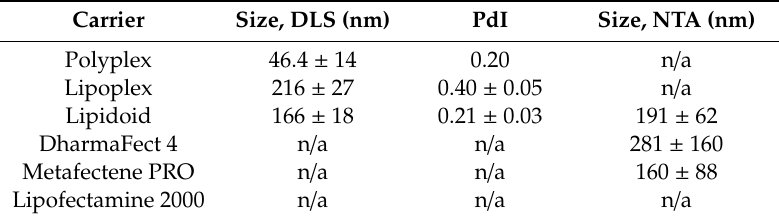
Table 1. Size and polydispersity index of siRNA / carrier complexes measured by dynamic light scattering (DLS), and size measured by nanoparticle tracking analysis (NTA).